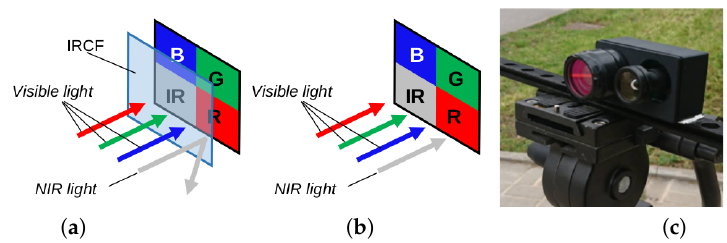
Figure 2. Illustration of ( a ) an infrared filtered imaging system (IRCF: infrared cut-off filter); ( b ) RGBN imaging system; ( c ) See3CAM-CU4 RGBN cameras used in the experiments. The infrared cut-off filter can be seen in the left side of the figure; it is used to generate the ground truth RGB